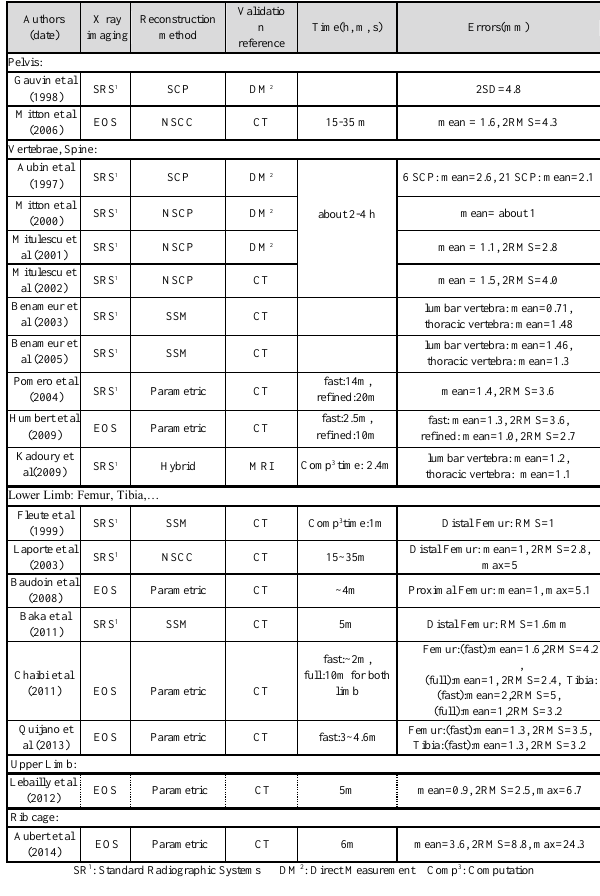
Table1: Evaluation of 3D Reconstruction methods from X ray images Authors X ray Reconstruction (date) imaging method